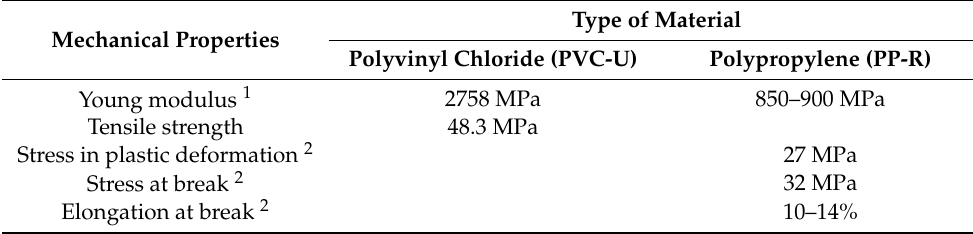
Table 2. Mechanical properties of polymer pipes [19].